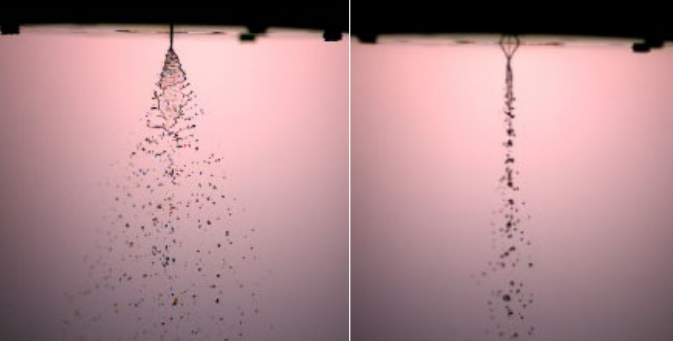
8 of 17 Figure 8. Schematic drawing of the injection hole section. Table 4. Design specifications of the injector. Item Design Impinging pattern